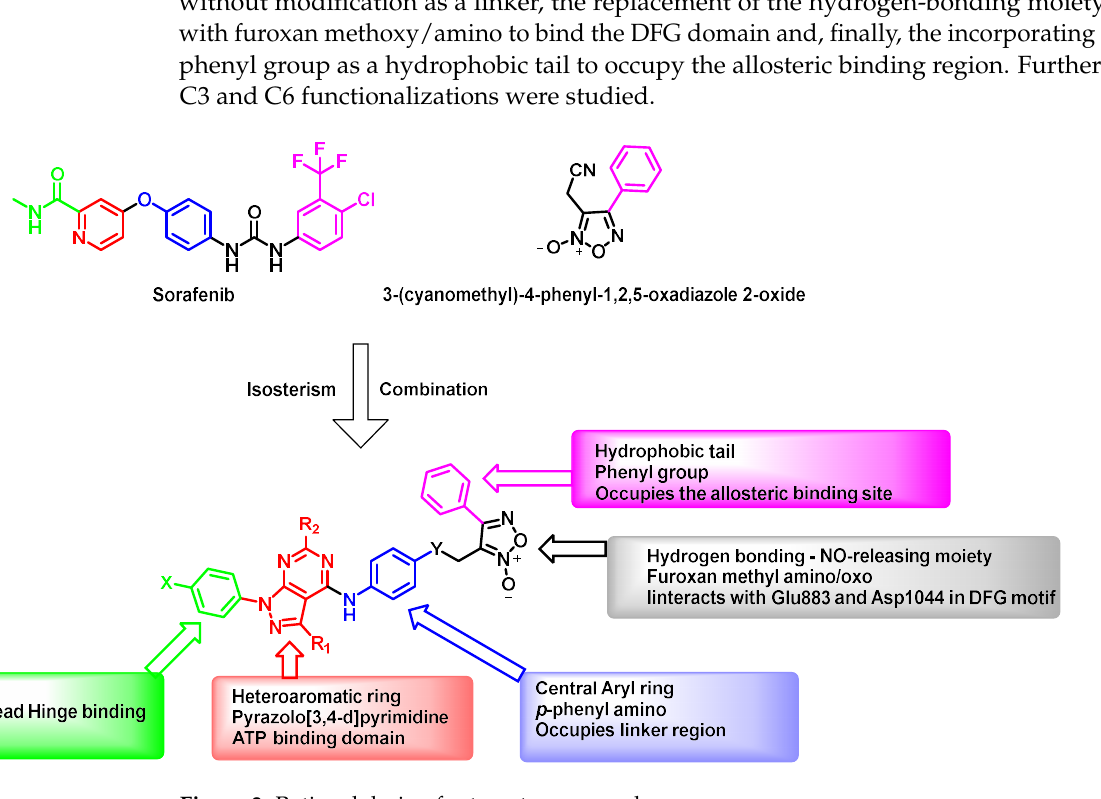
Figure 3. Rational design for target compounds.